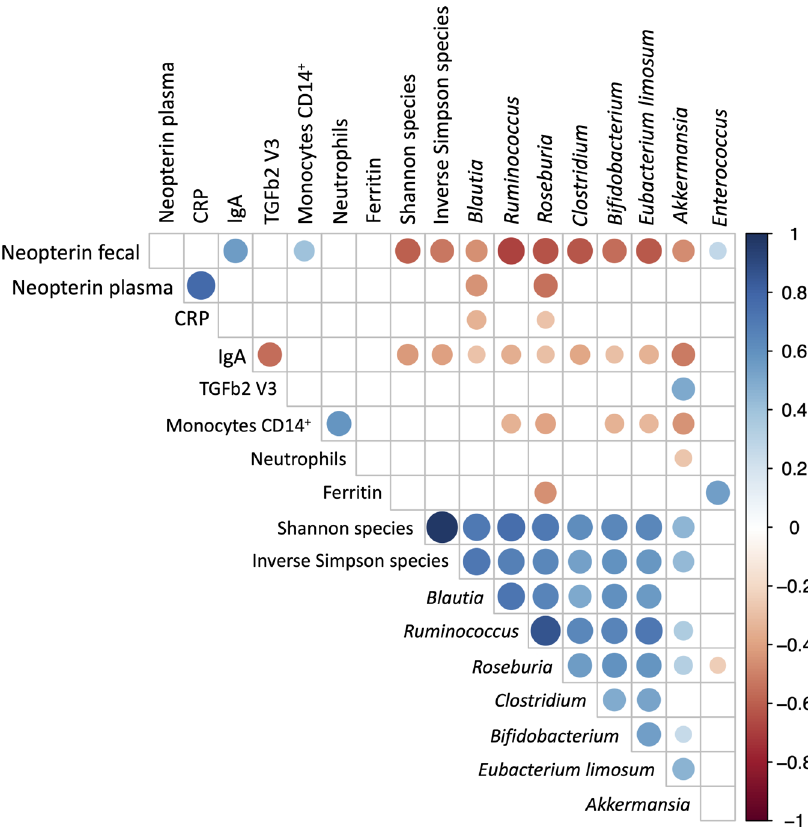
Fig. 6 Correlation between host and microbiota parameters ( n = 20). Spearman pairwise correlation. Only signi fi cant correlations are depicted. Blue = positive correlation; Red = negative correlation. Correlations are calculated from the values measured in all patients at all visits (except for TGF β 2 for which only the values measured at visit V3 are considered). CRP is for C-Reactive Protein; IgA, immunoglobulin A; TGF β 2_V3, Transforming growth factor-beta 2 at visit 3; CD14_pos, cluster of differentiation 14 positive. Source data are provided as a Source Data fi